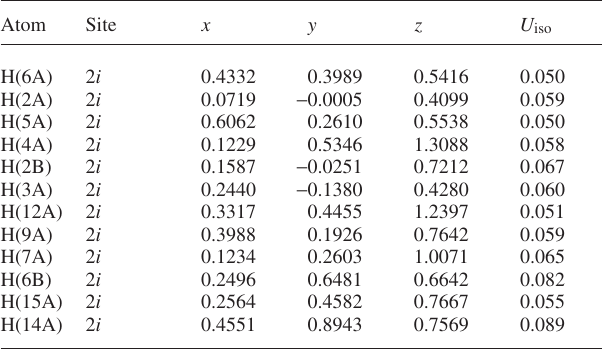
Table 2. Atomic coordinates and displacement parameters (in Å 2 )